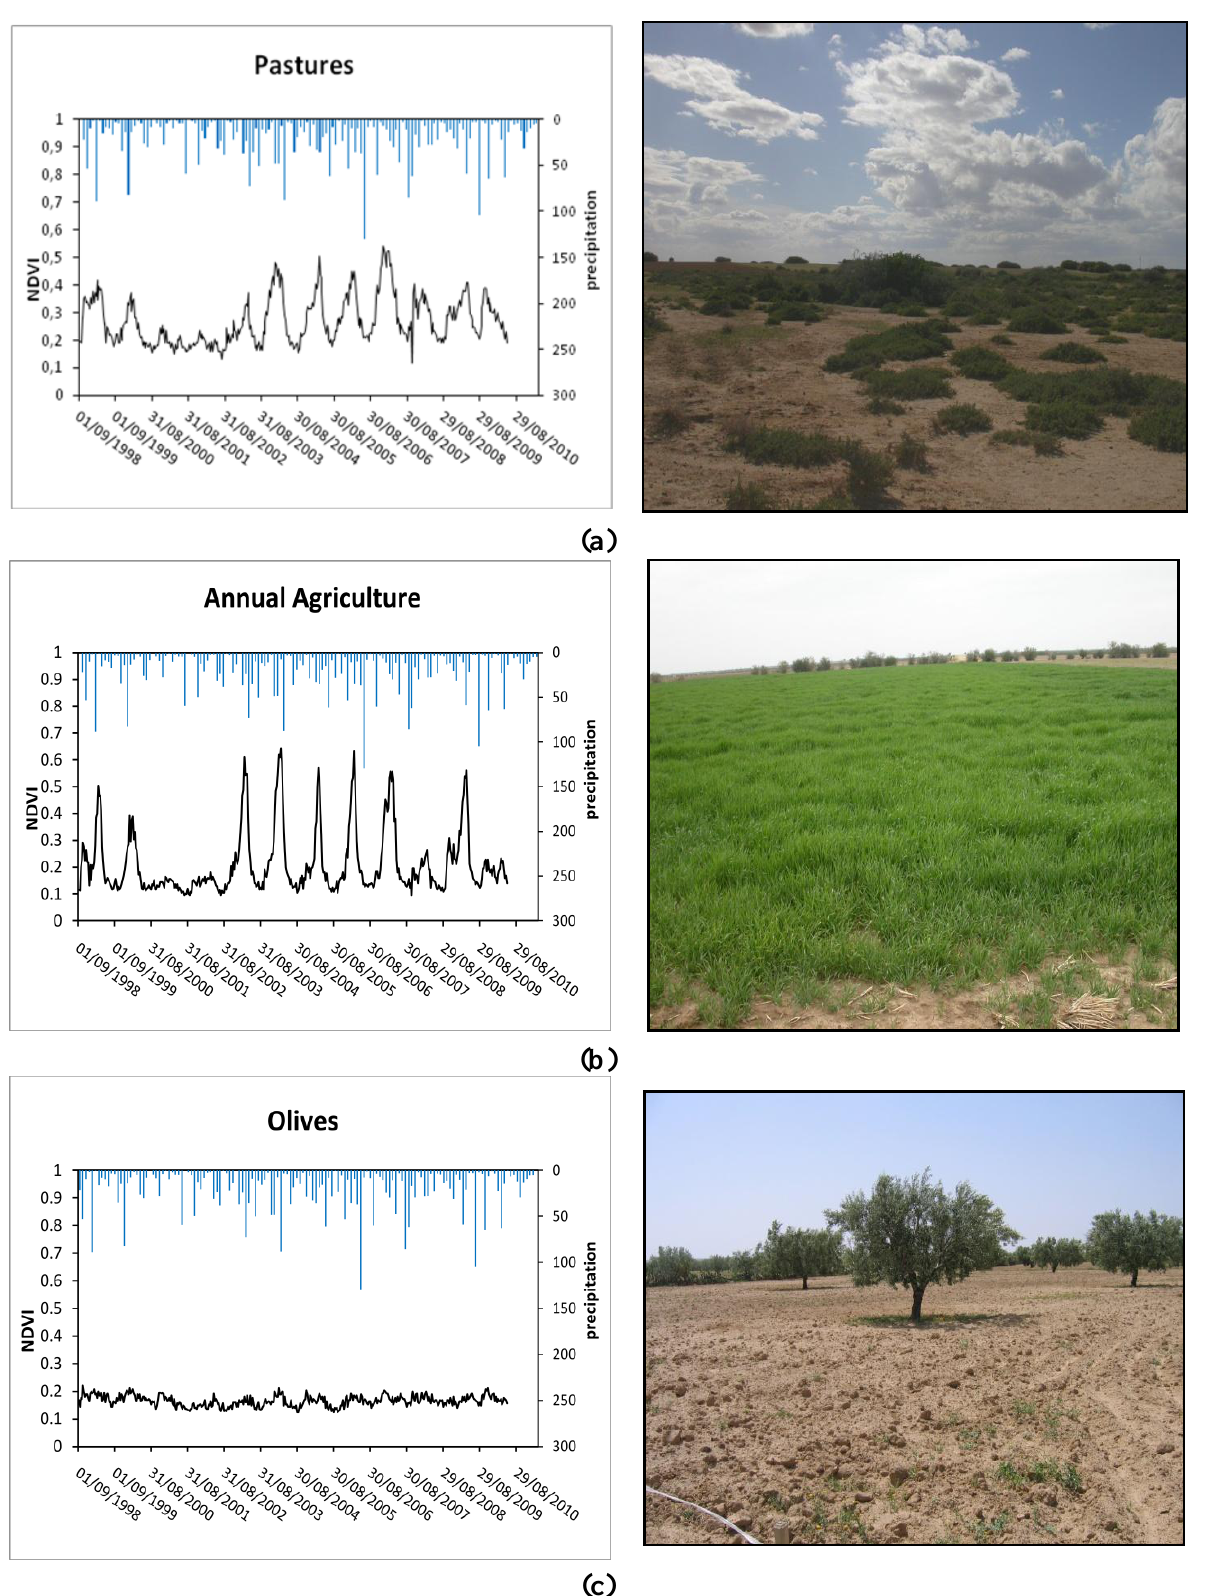
Figure 3. Temporal variations of the spatially averaged NDVI for three types of vegetation cover, from September 1998 to June 2010: (a) pasture, (b) annual agriculture and (c) olive groves. The scale of the abscissa is in units of 1 ―decade‖ (= 10